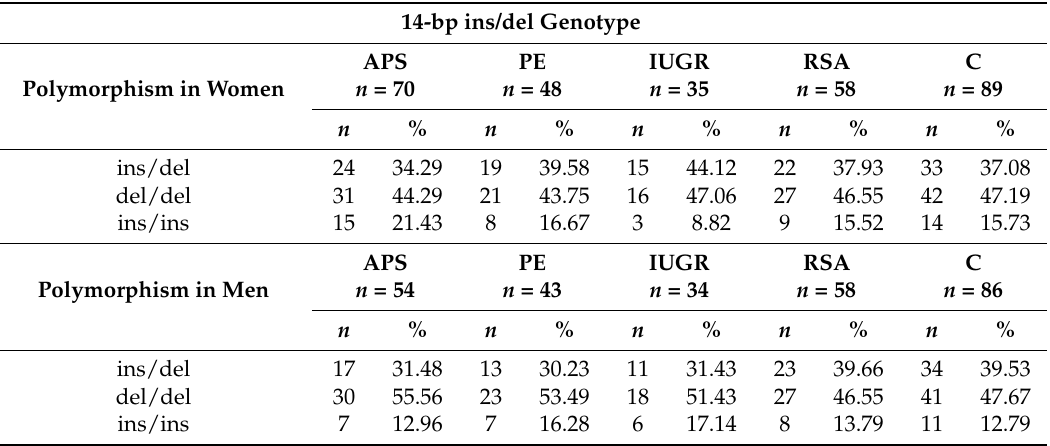
Table 6. The frequencies of the 14-bp ins/del polymorphism in the 3 (cid:48) -UTR of the HLA-G gene in the women with antiphospholipid syndrome, preeclampsia, intrauterine growth restriction, recurrent spontaneous abortion and their partners and in the control group.